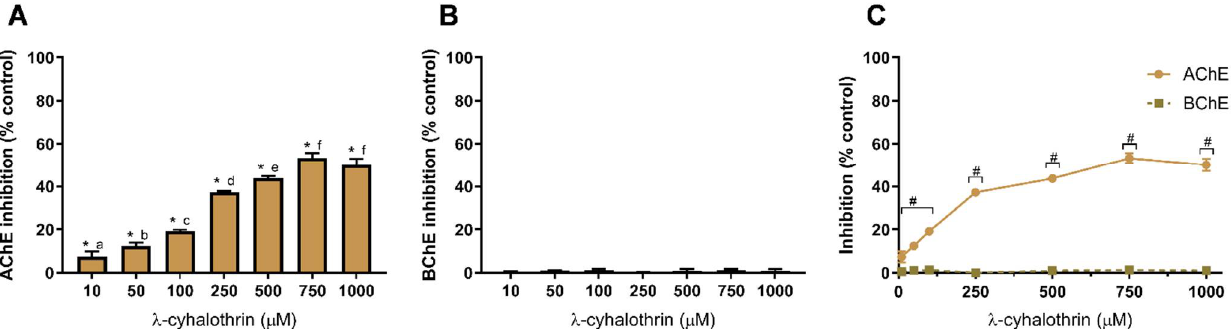
Figure 5. λ -cyhalothrin-induced inhibition of AChE ( A ) and BChE ( B ), and comparison of cholinesterases affinity ( C ). Values are expressed as mean ± SD. Significant statistical differences between samples and the control are denoted by “*” when p < 0.05 ( A , B ), and differences between enzymes at the same concentration are denoted by “#” when p < 0.05 ( C ). Different letters are used to denote significant differences between concentrations when p < 0.05 ( A ). Statistical analysis details are described in methods (Section 2.3) and in Table S1.